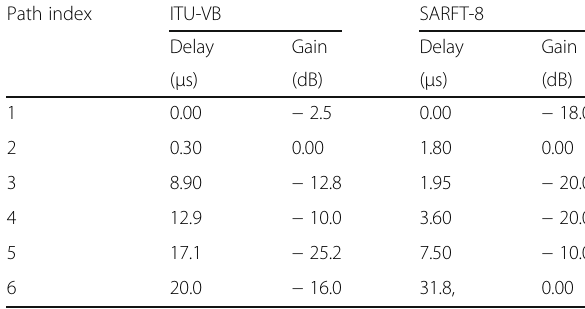
Table 2 Multipath channel parameters for